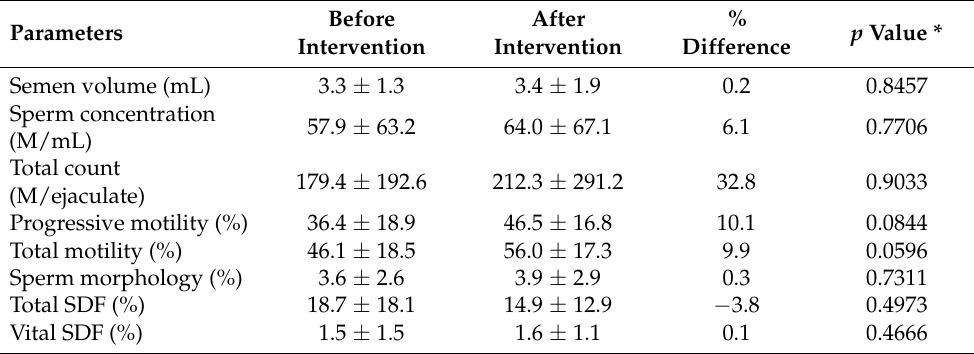
Table 6. Semen and SDF parameters in the subfertile group before and after intervention.